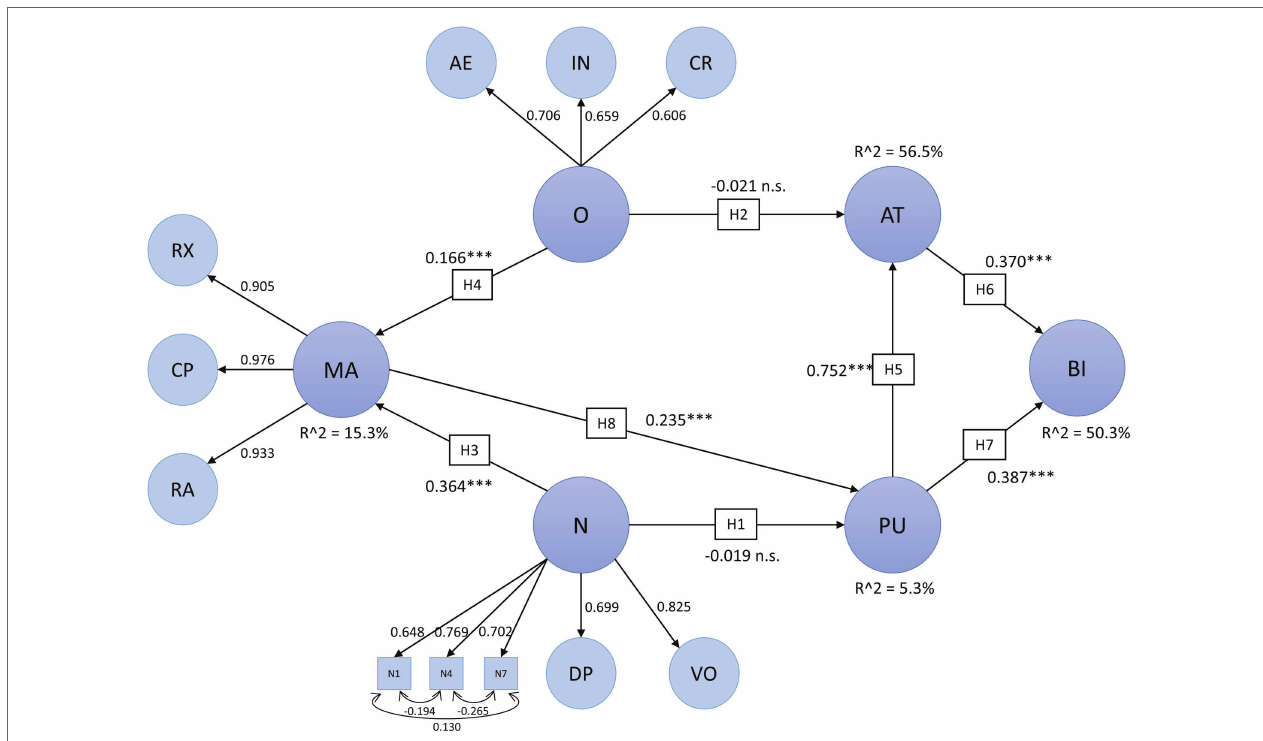
FIGURE 6 | Full SEM results. All path coefficients are standardized regression coefficients. AE, aesthetic interest; AT, attitude toward using MSS; BI, intention to use MSS; CP, cognitive problem solving; CR, creative imagination; DP, depression; FE, fear; IN, intellectual curiosity; MA, modulation of negative affect through music; N, neuroticism; O, openness; PU, perceived usefulness of MSS; RA, reduction of negative activation; RX, relaxation; and VO, emotional volatility. ∗∗∗ significant with p <